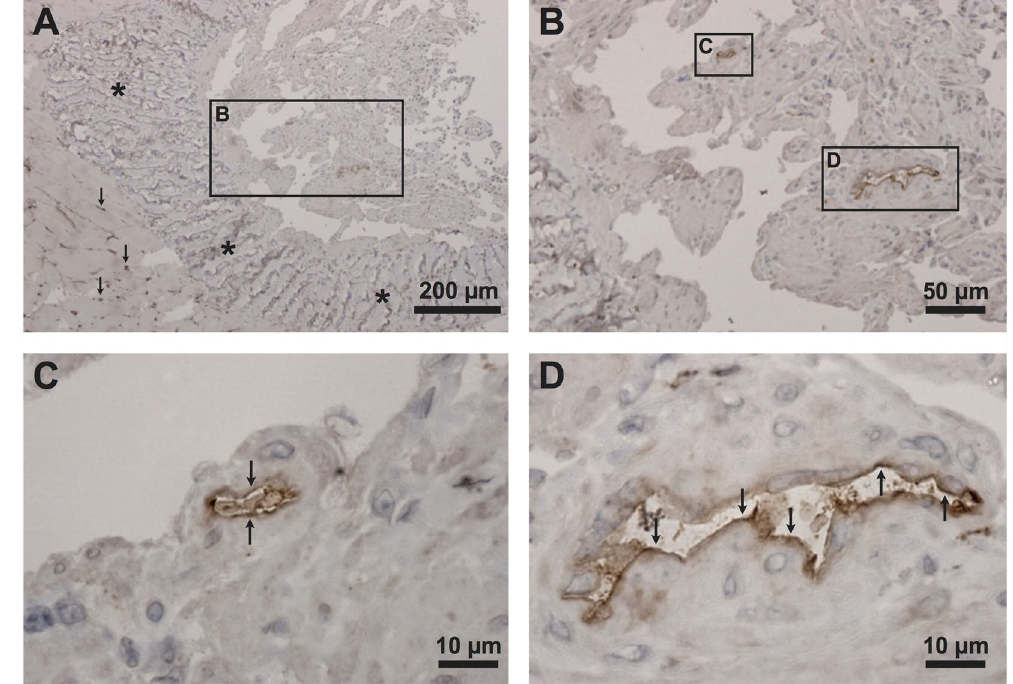
Figure 2. Immunolocalization for K Ca 2.3 channels in wild type (WT) mouse corpus cavernosum. ( A ) Histological image of penile tissue from a WT mouse. The square area represents part of the corpus cavernosum. The corpus cavernosum is surrounded by the albuginea layer (asterisks) and skeletal muscle. Arrows indicate K Ca 2.3 labeling in capillaries between the skeletal muscle fibers. ( B ) Histological image showing an enlargement of the square area representing the corpus cavernosum from panel A. K Ca 2.3 immunoreactivity is seen in blood vessels of the corpus cavernosum (inset C and D ). ( C ) K Ca 2.3 expression in the apical plasma membrane domains of endothelial cells of a small helicine artery in the corpus cavernosum (arrows, enlargement of inset C ). ( D ) Similar K Ca 2.3 expression in the apical plasma membrane domains of endothelial cells of a probable larger artery in corpus cavernosum (arrows, enlargement of inset D